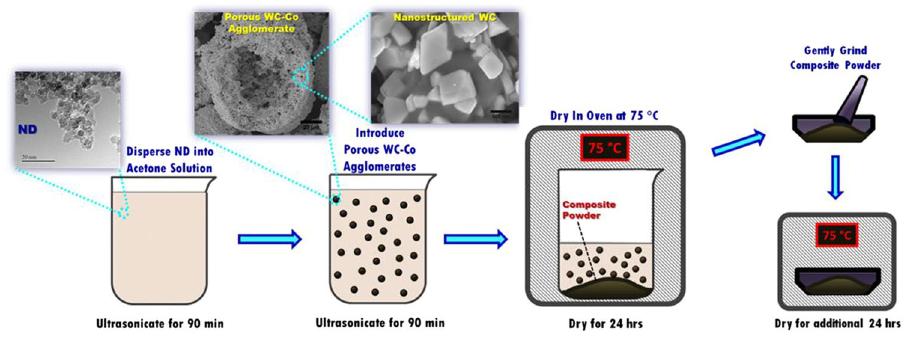
Figure 1. Schematic diagram of composite powder synthesis route including TEM and SEM of starting powders.